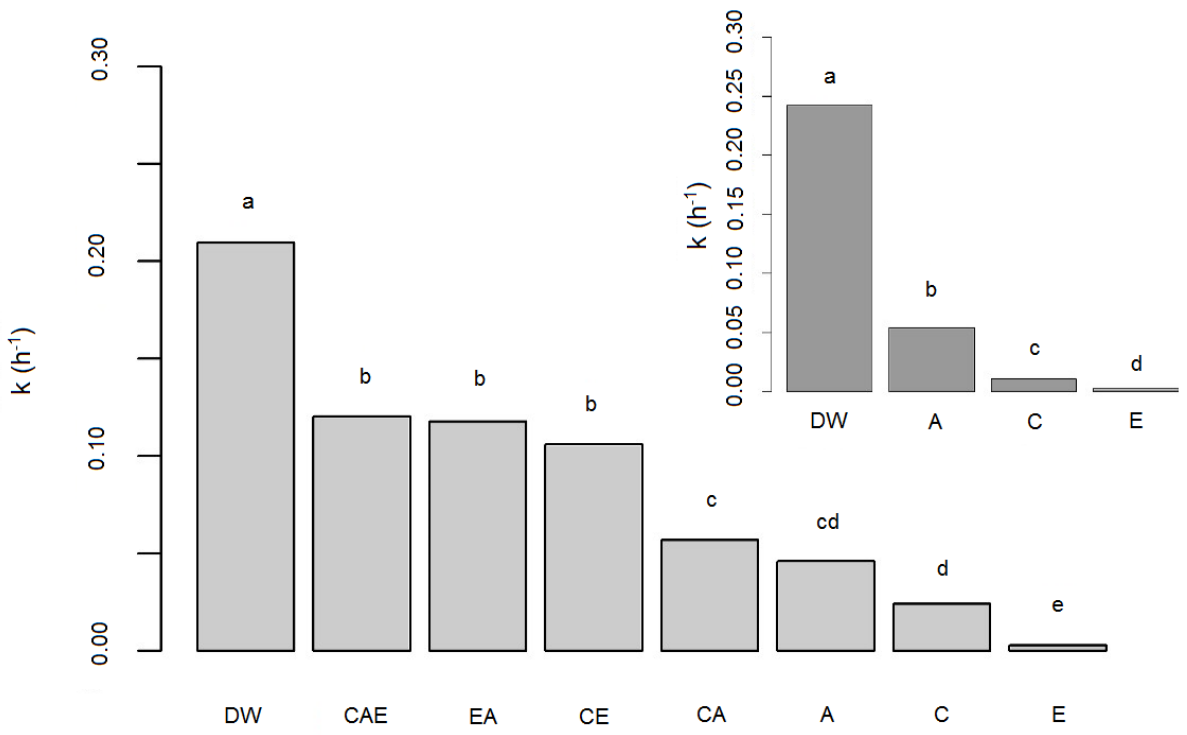
Figure 6. Vitamin D3 stabilization, presented by its first-order rate constants at 25 ◦ C in distilled water (DW) and after the addition of an individual antioxidant EDTA (E), citric acid (C), ascorbic acid (A), and combinations of two and all three antioxidants (CA, CE, EA, and CAE) ( n = 3). The columns designated by different letters showed statistical differences from the other groups ( p < 0.001). Insert—The effect of the same concentration (0.5 g/L) of citric acid (C), ascorbic acid (A), or EDTA (E) on vitamin D3 degradation rate at 25 ◦ C ( n = 3). The columns designated by different group letters showed statistical differences from other groups ( p < 0.001).